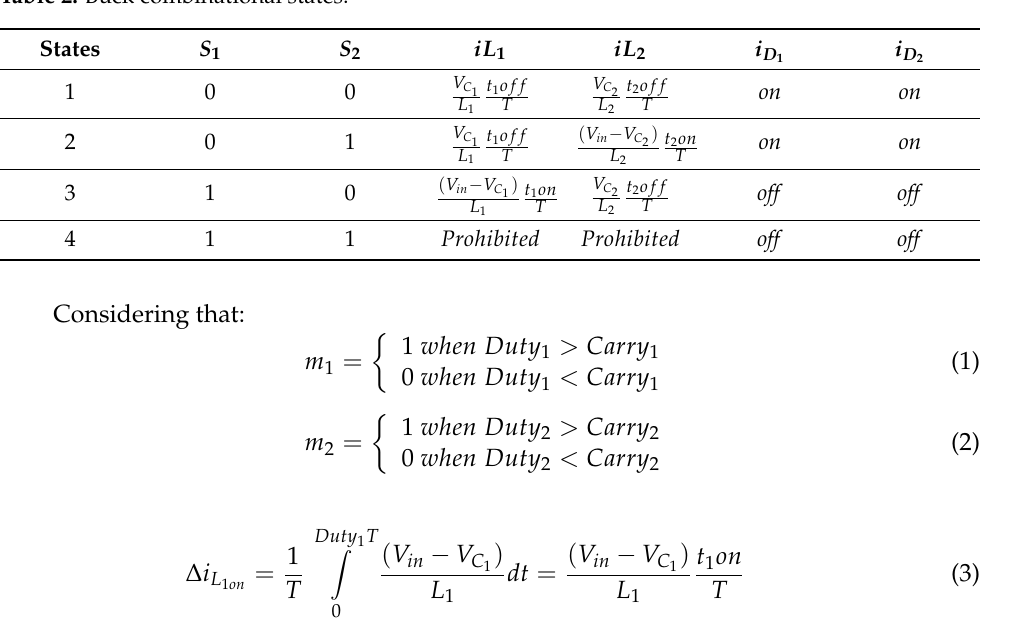
Figure 7. Proposed buck variant topology in switching state S 1 =1, S 2 = 0 with highlighted currents paths. Table 2. Buck combinational